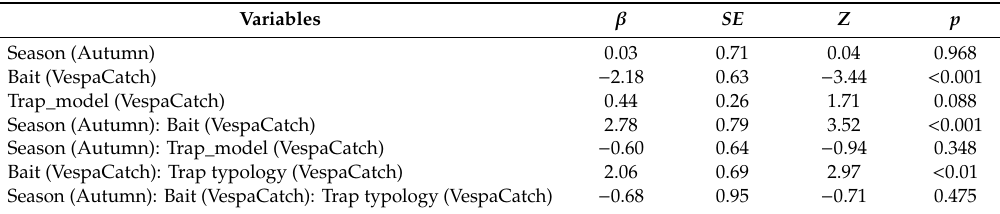
days). Comparison between the selected model (AIC 436) and the null-model (AIC 521): χ 2 = 101, df =